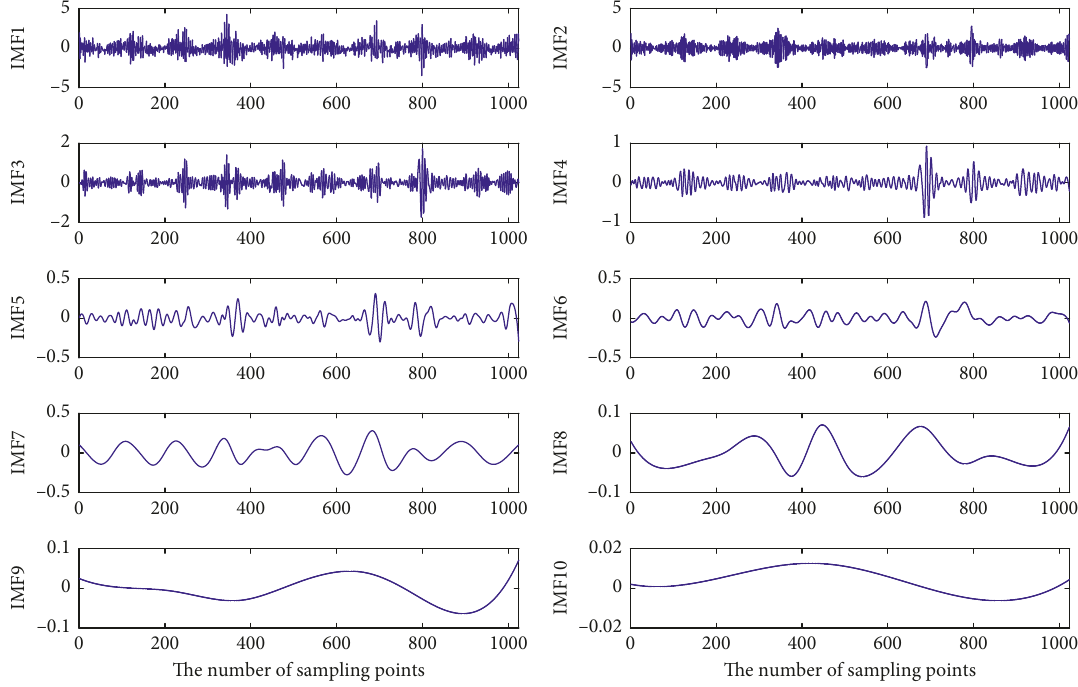
Figure 10: The EEMD decompose results of X -directional vibration signals.